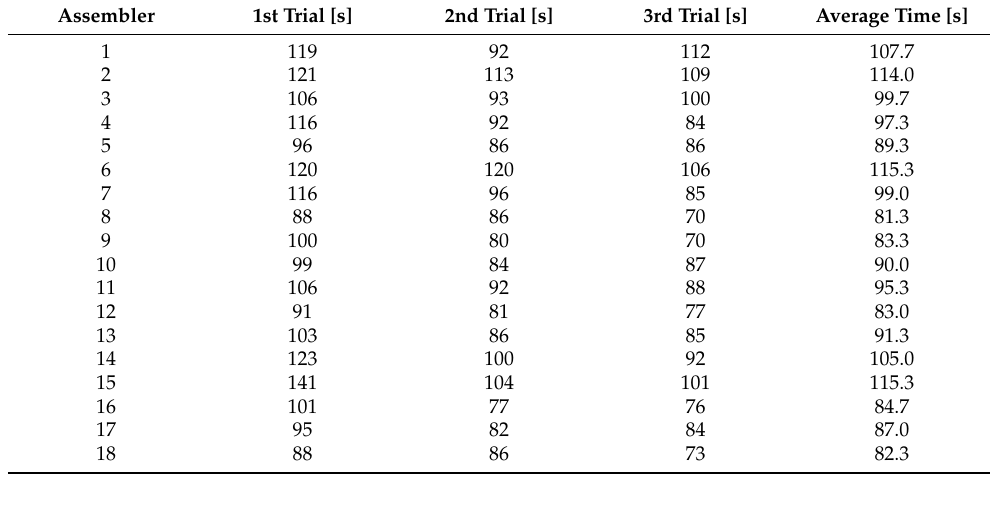
Table 6. Assembly time using guided instructions with P2L modules.